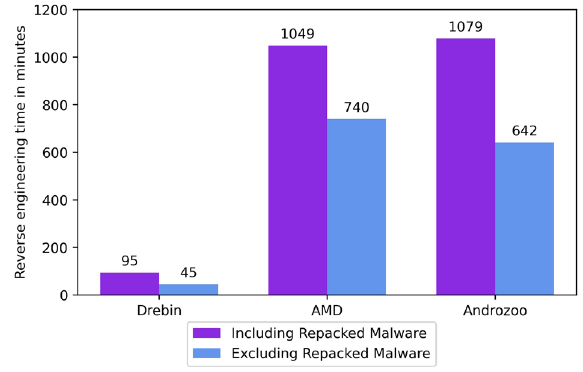
Figure 6. Features extraction time